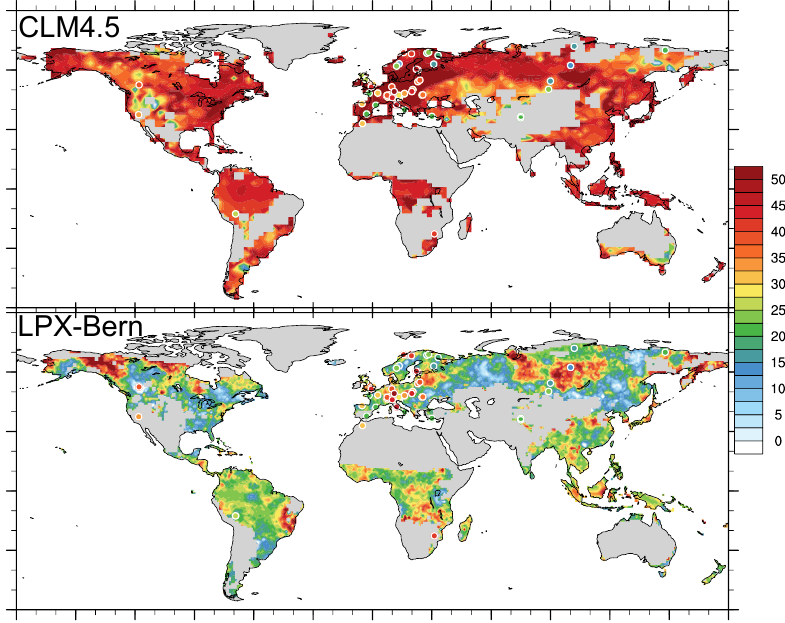
Figure 11. Century-scale changes in iWUE (%) of C3 trees as calculated from δ 13 C tree-ring data (colored circles) and (a) CLM4.5 and (b) LPX model results. The changes are based on decadal means (1990s minus